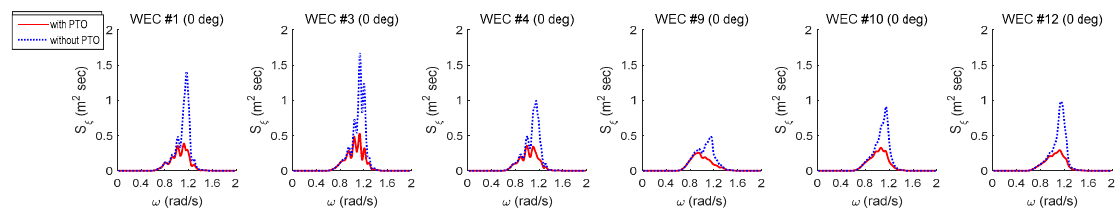
Figure 15. JONSWAP spectrum of the installation site for H 1/3 = 1.0 m, T P = 6.67 s, γ = 1.0.